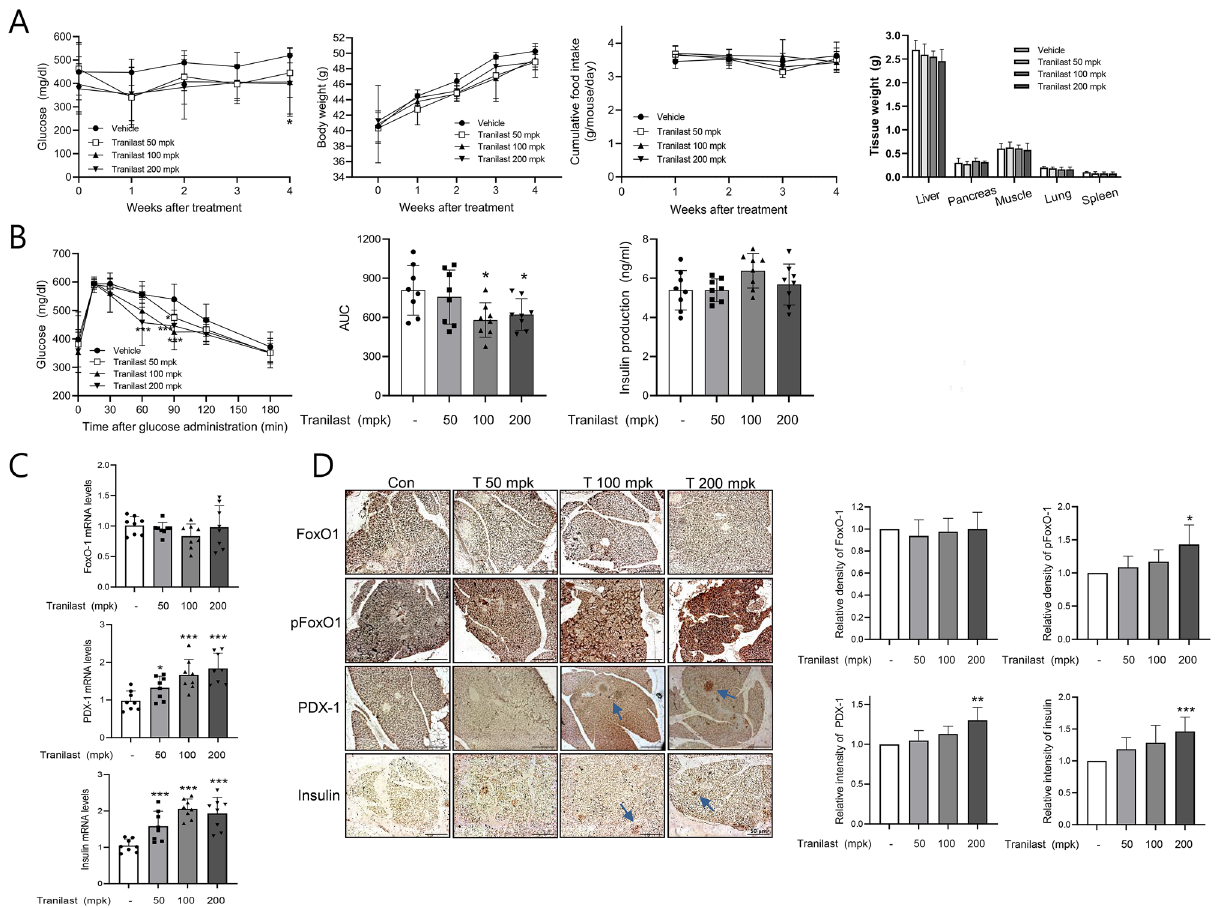
Figure 8. Chronic in vivo effect of tranilast was studied using db/db mice. Male db/db mice (8-weeks old) were orally administered either vehicle (0.5% CMC) or tranilast (50, 100, and 200 mg/kg) once daily for 4 weeks (n = 8 per group). (A) Non-fasting blood glucose, body weight and food intake were determined once a week. At the end of treatment, tissues were isolated and weighed. (B) After overnight fasting, oral glucose tolerance test was carried out after 4 weeks of tranilast administration. Area under the curve and fasting plasma insulin levels were determined. (C) mRNA levels of PDX-1, insulin, and FoxO-1 in whole pancreas were measured by real- time qPCR. (D) Representative pancreatic sections with immunohistochemical staining of pFoxO-1, FoxO-1, PDX-1, and insulin are shown (scale bar = 50 μm). The results of quantitative analysis were shown in the right panel. * p < 0.05, ** p < 0.01, *** p < 0.005 versus vehicle